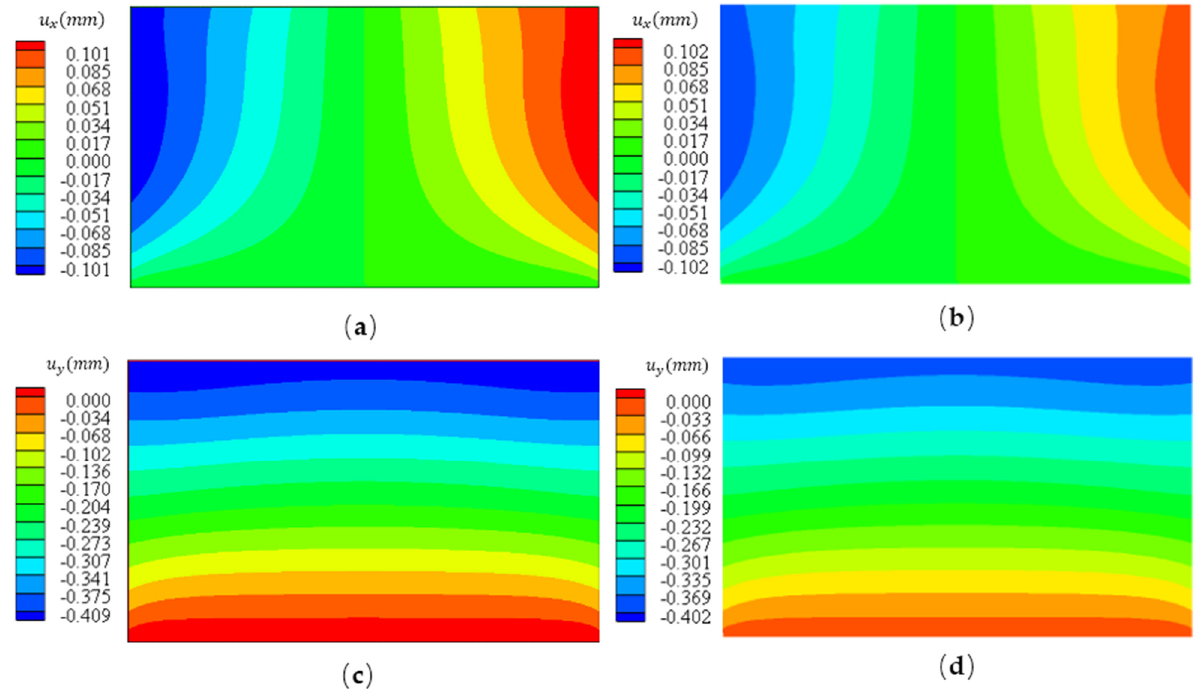
Figure 7. Comparison of displacement contours by using FEM and PD (unit: mm). ( a ) Horizontal displacement by FEM; ( b ) horizontal displacement by PD; ( c ) vertical displacement by FEM; ( d ) vertical displacement by PD.